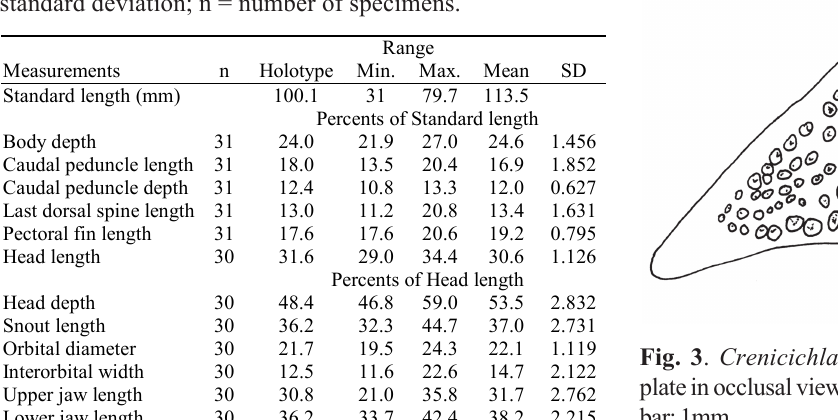
Table 1 . Morphometrics of Crenicichla hadrostigma . SD = standard deviation; n = number of